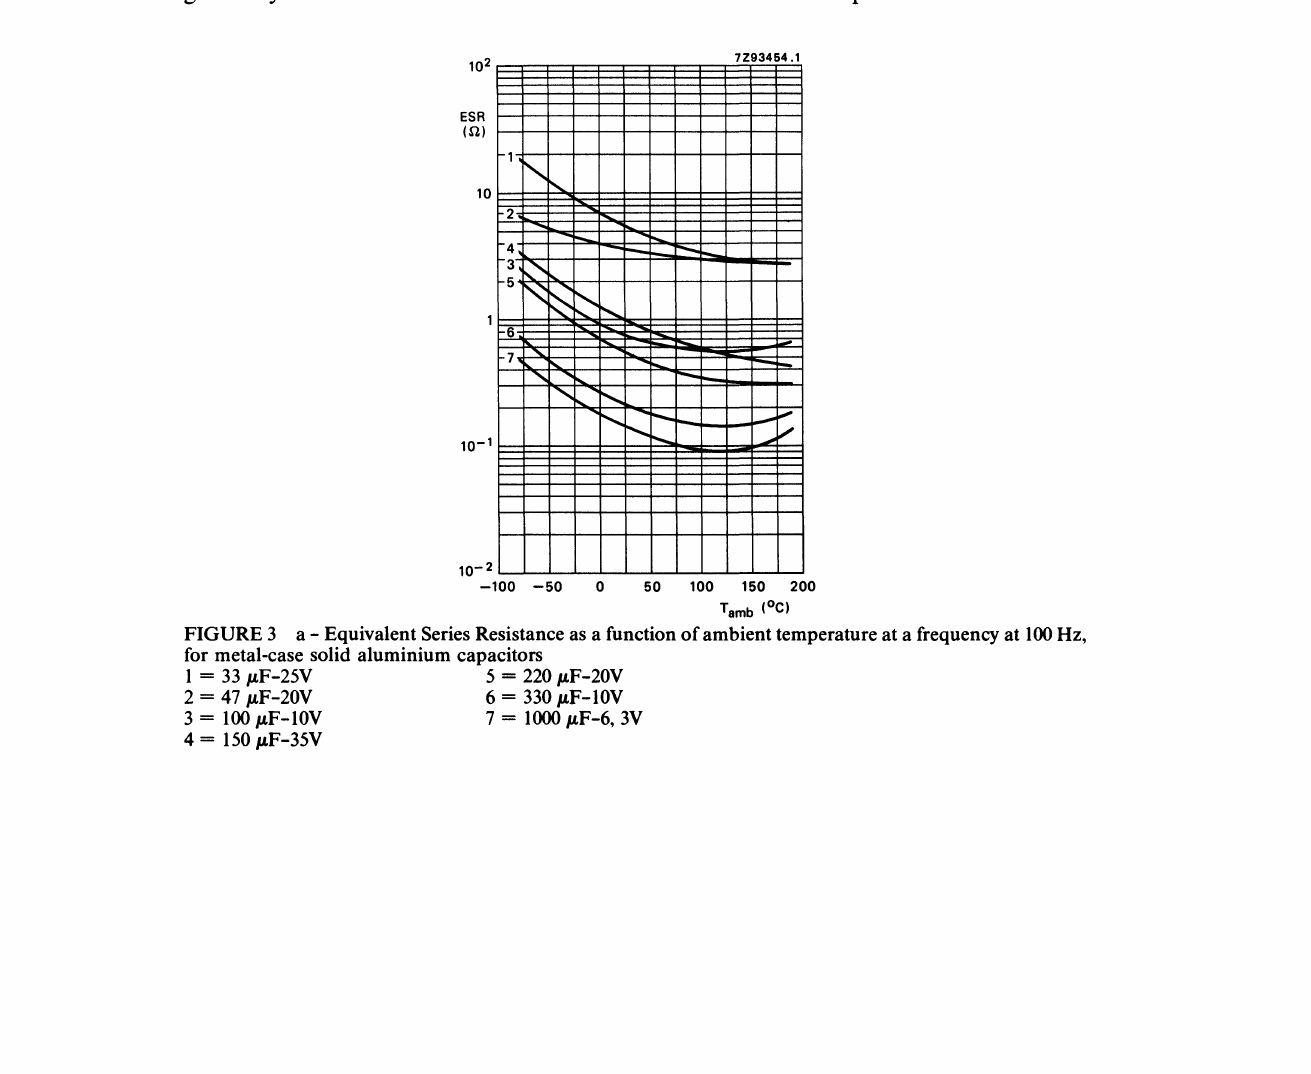
FIGURE 3 a Equivalent Series Resistance as a function of ambient temperature at a frequency at 100 Hz, for metal-case solid aluminium capacitors 33